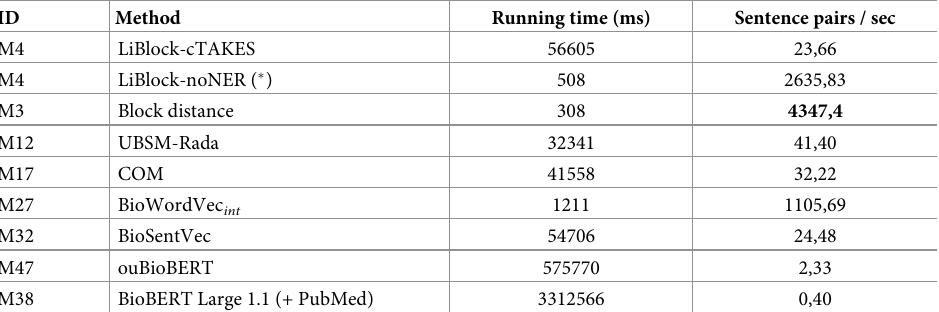
Table 18. This table shows the running times in milliseconds (ms) and the average sentences pairs per second (sent/sec) reported by the best-performing method of each family of methods in the evaluation of the 1339 sen- tence pairs that comprise the three datasets. ( � ) The LiBlock method reports the running times in both NER and noNER versions showing that the efficiency of the method with no NER tool is much higher, despite the fact that there is no statistically significant difference in the results between both pre-processing